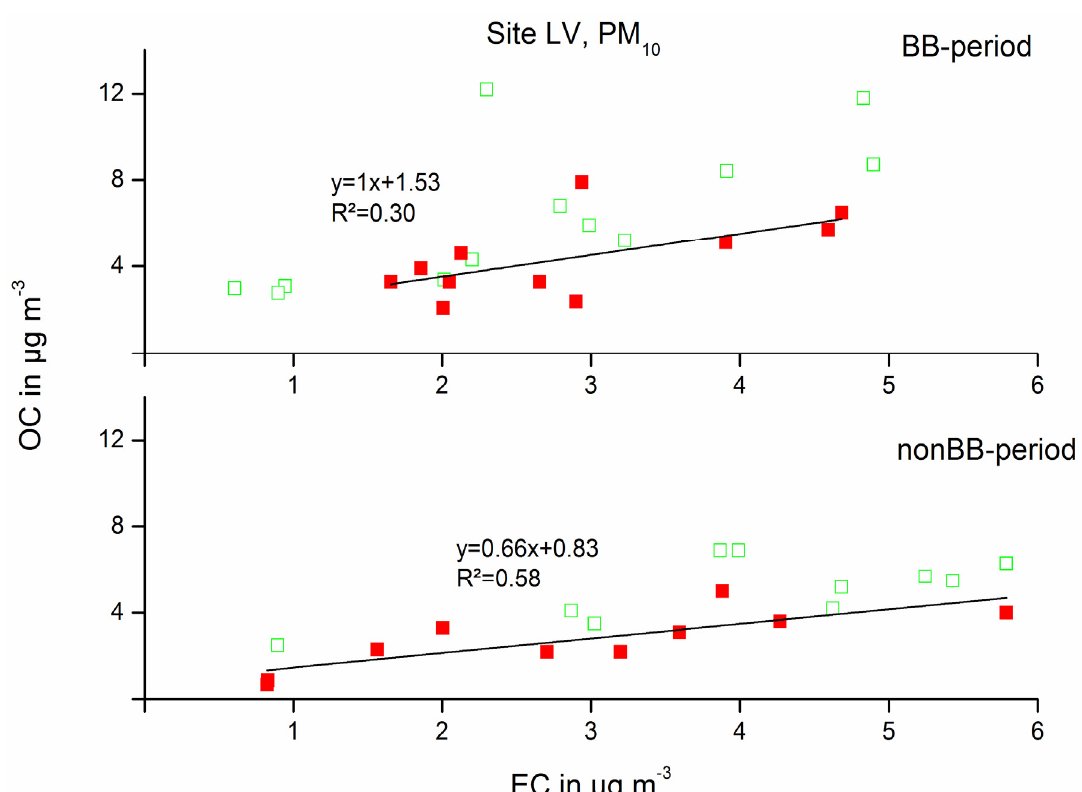
at site LV, PM p